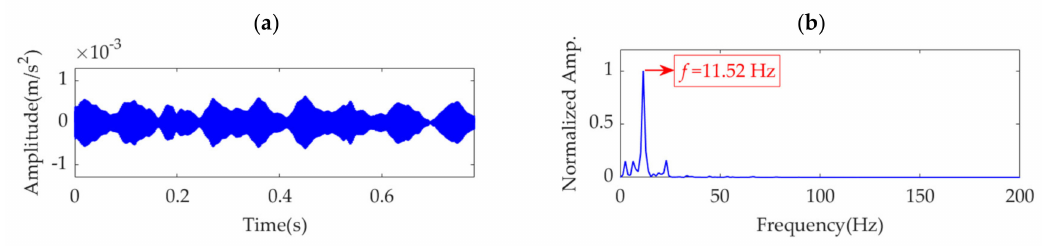
Figure 25. Target mode obtained using VMD: ( a ) time–domain waveform and ( b )